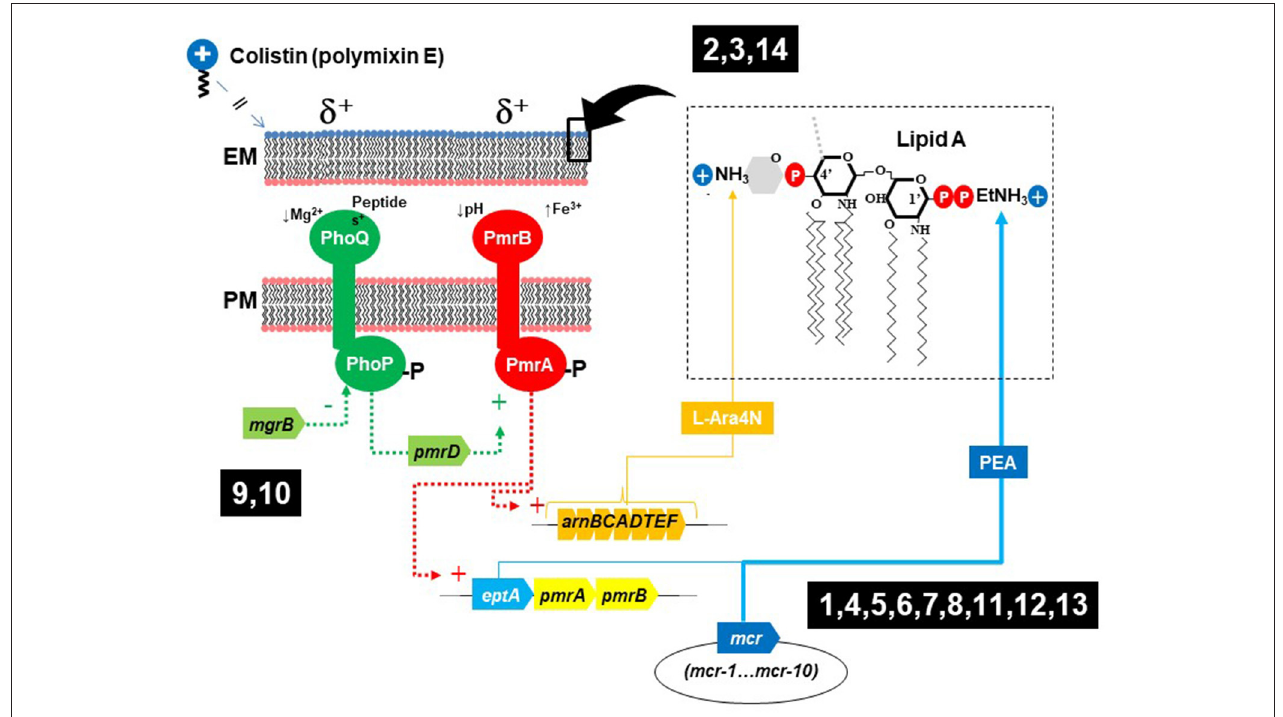
FIGURE 1 | Elements involved in colistin resistance in enterobacteria, biological context of the articles published in this research topic. (1, Cheng et al.; 2, Zhu et al.; 3, Miguela-Villoldo et al.; 4, Hiba Al-Mir et al.; 5, Nakano et al.; 6, Savin et al.; 7, Lopes et al.; 8, Zhang et al.; 9, Ngbede et al.; 10, Azam et al.; 11, Hu et al.; 12, Vázquez et al.; 13, Diaconu et al.; 14, Panta and